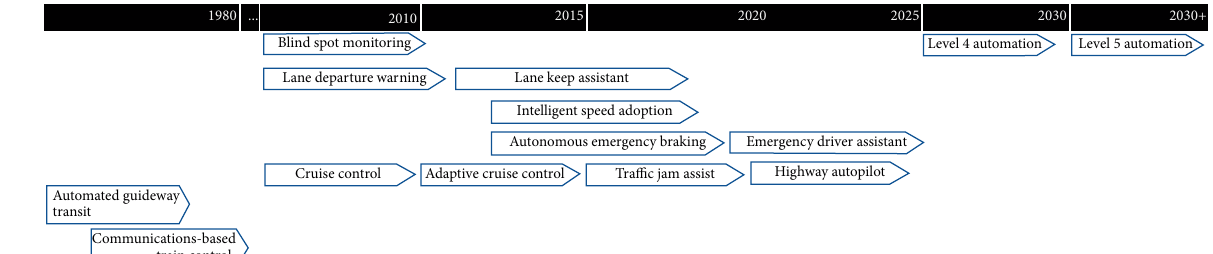
Figure 1: AV levels (adapted from SAE).